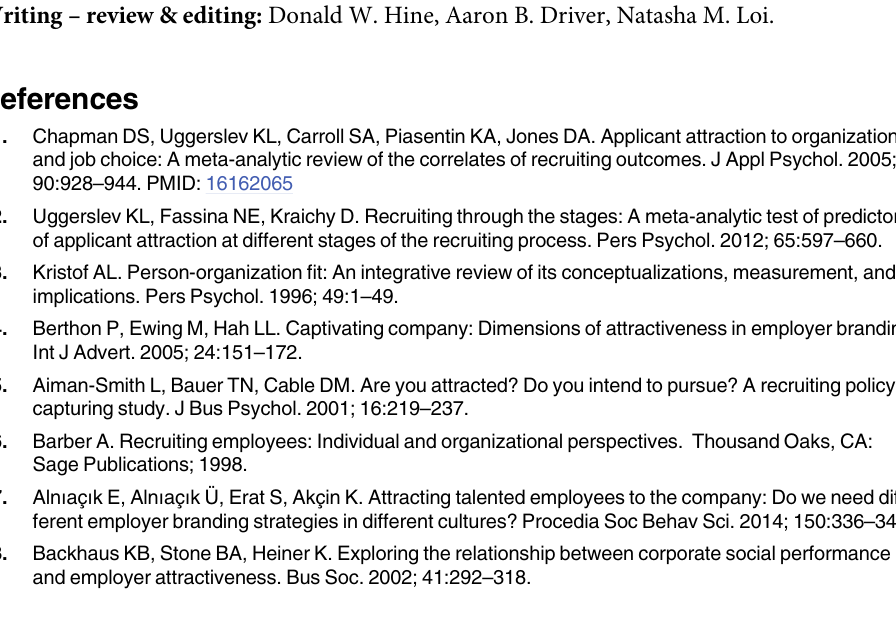
S1 Table. High and low descriptors for workplace attributes. S2 Table. Level 1 analysis: Workplace attributes predicting organization attractiveness. S3 Table. Level 2 analyses: Job seekers’ personal values predicting level 1 effects. S1 Fig. Cross-level interactions between personal values and workplace attributes predict- ing job-seekers’ perceptions of organizational attractiveness. S2 Fig. Non-significant cross-level interactions between personal values and workplace attributes predicting job-seekers’ perceptions of organizational